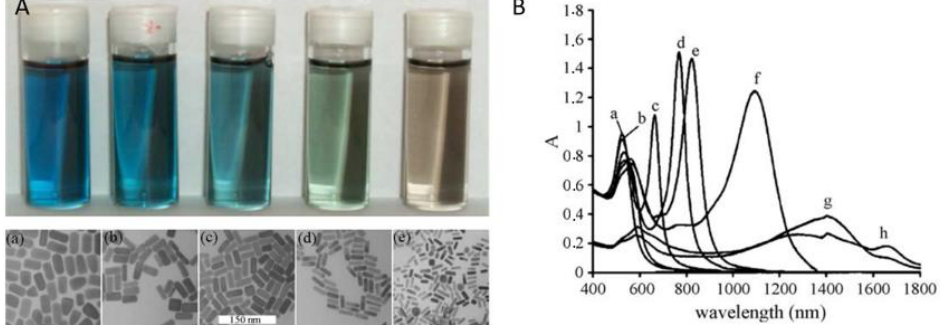
Figure 1. ( Α ) The changes in aspect ratio of AuNRs induce drastic changes in transmitted colors